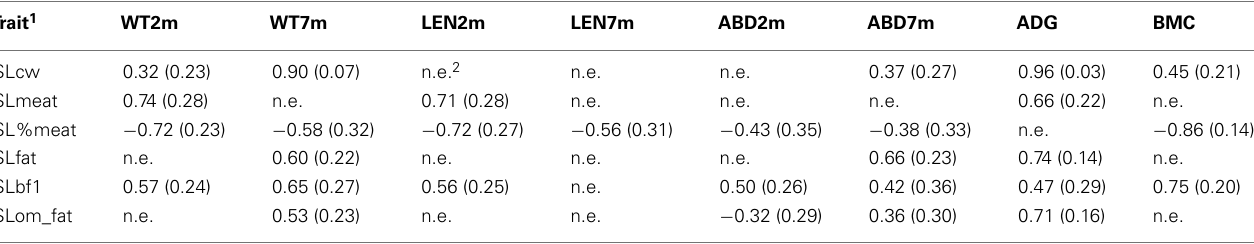
Table 5 | Genetic correlations of slaughter traits with weight and conformation with standard errors, estimated by individual animal model using all 563